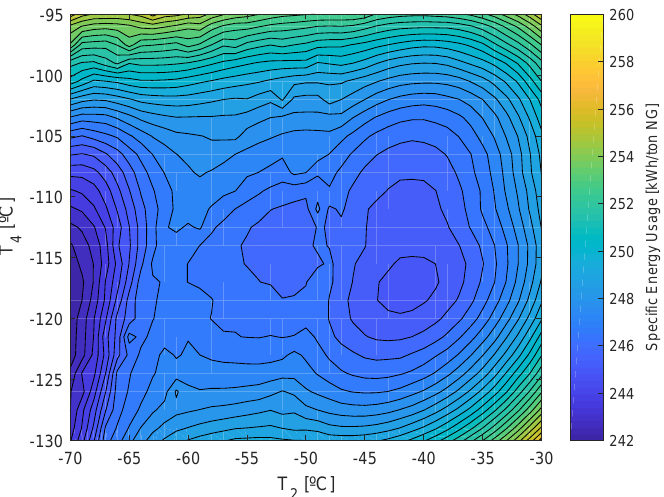
Figure 4. Illustration of locale minima in the specific energy consumption for partly optimized 2-2-2-Cascade processes where T 2 and T 4 are kept fixed in the optimization. The minimum pressure requirement is ignored in this illustrative example.